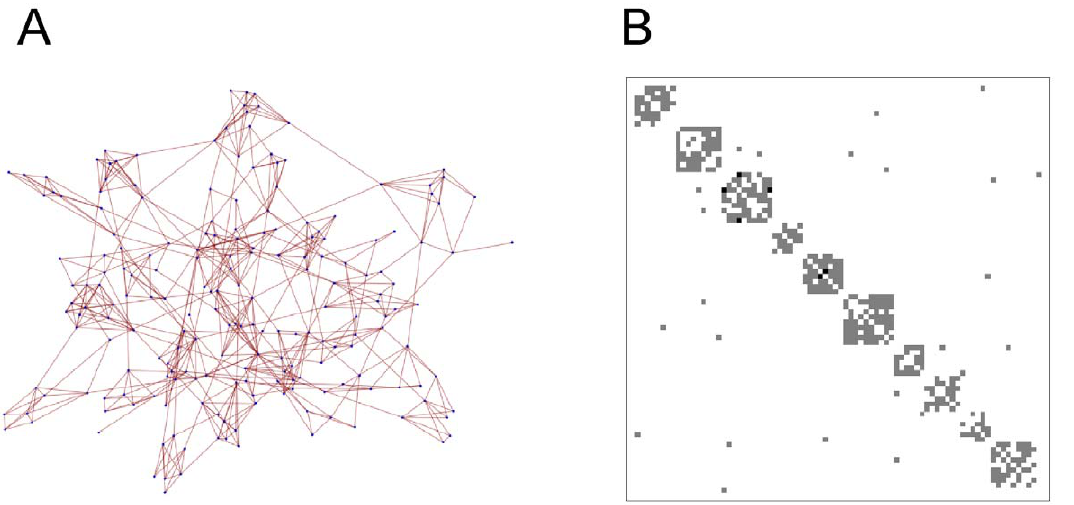
Figure 1. Network structure and connectivity matrix. In (a), a typical example of the 200-vertex network architecture used to model community structure is shown. In (b) we represent the connectivity between the first 80 vertices of this network as a connectivity matrix, where grey squares represent connections between pairs of vertices. Note the clustering (represented as higher connectivity along the main diagonal), the symmetry (the non-directed nature of the interaction between vertices) and its overall sparseness (most pairs of vertices remain unconnected).